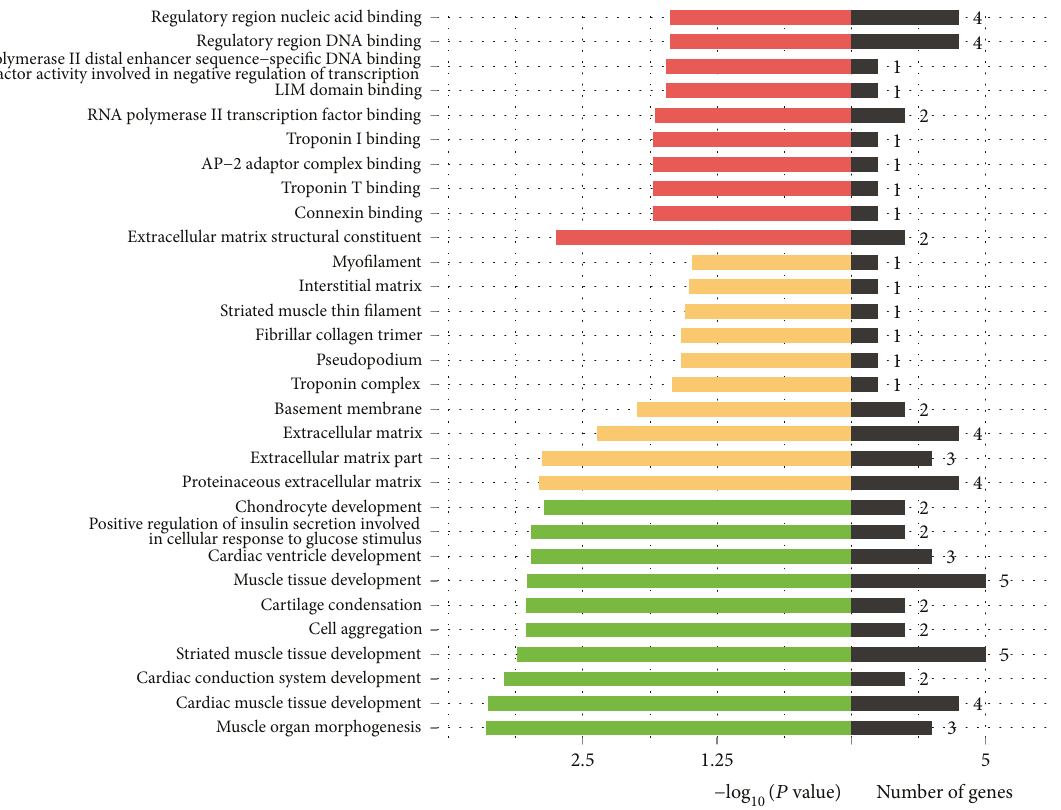
Figure 4: DEGs ’ GO enrichment classi fi cation. Red bars represent the molecular function. Yellow bars represent the cellular component while the green represents the biological process.